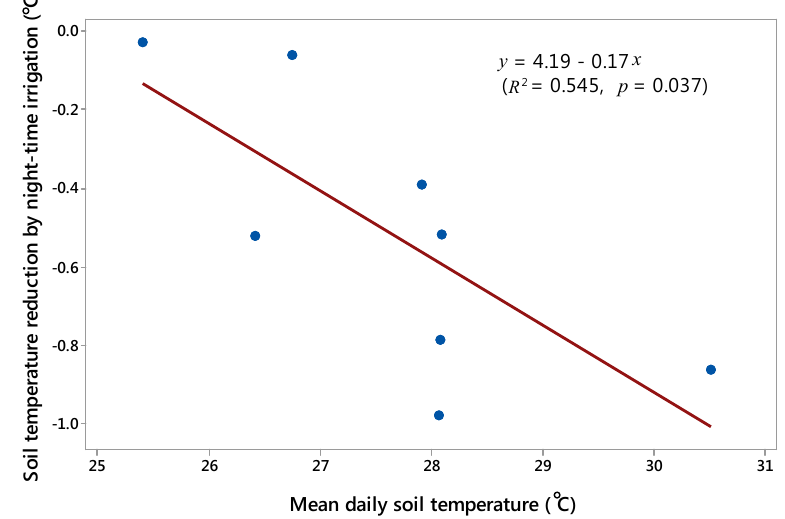
Figure 3. Relationship between the extent of soil temperature reductions due to night-time irrigation and mean daily soil temperature. The vertical axis was defined as the difference between soil temperatures in night-time irrigated plots and those in day-time irrigated ones during the 24 h following the irrigation application. Data points are based on irrigation events over 8 days (19 May, 22 May, 9 June, 12 June, 19 June, 25 June, 30 June, and 9 July 2014) when soil temperature measurement was available. This figure shows that night-time drip irrigation reduced soil temperature at a greater extent on warmer days. Standard deviations of the temperatures shown on both axes are collected in Supplementary Materials Table S1.